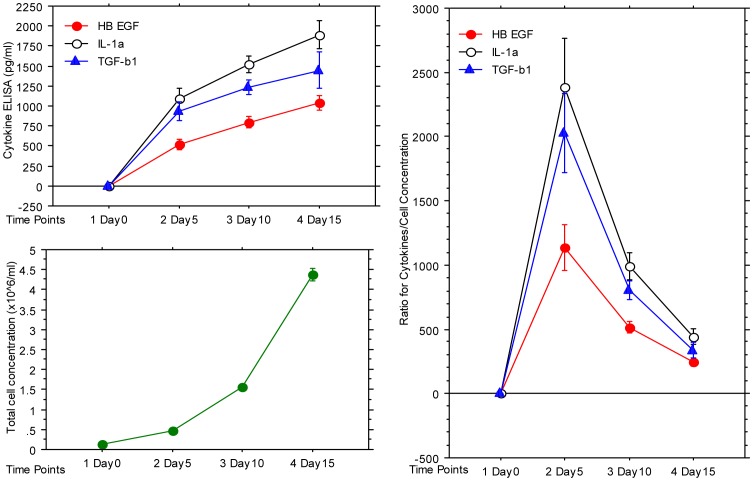
The relationships between cell concentration and HB-EGF, IL-1α, and TGF-β1 concentrations.Fibroblasts (3.0×105 cells) and keratinocytes (1.0×106 cells) were cultured in 6-well plates. The supernatant and cells that contained both keratinocytes and fibroblasts from 4 wells were harvested at each time point. The cells were then resuspended in 5 ml for counting. The cytokine concentrations were measured by ELISA. (6A) HB-EGF, IL-1α, and TGF-β1 concentrations at different time points. (6B) Total cell concentration (containing both keratinocytes and fibroblasts) at different time points. (6C) The ratio of HB-EGF, IL-1α, and TGF-β1 concentrations over the total cell concentration (×106/ml) at different time points.